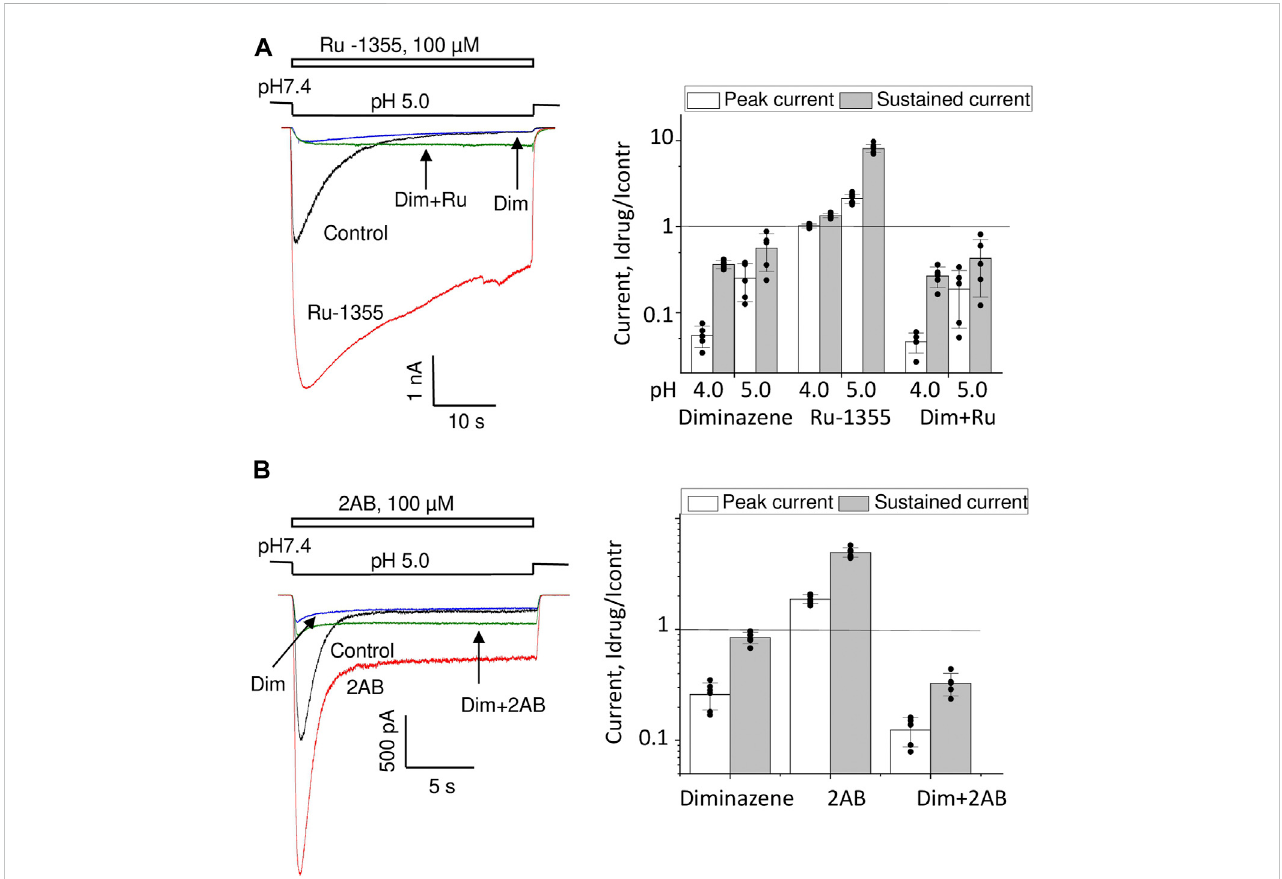
FIGURE 9 Action of diminazene (70 μ M) on ASIC2a (A) and ASIC3 (B) in the control condition and in the presence of potentiators. Responses in the control condition are shown in black, in the presence of potentiators are shown in red, in the presence of diminazene are shown in blue, and in the presence of both potentiators and diminazene are shown in green. In all cases, the peak component of the response is strongly inhibited, whereas the effect on the sustained component is much weaker. The right panels summarize the effects on the peak and sustained